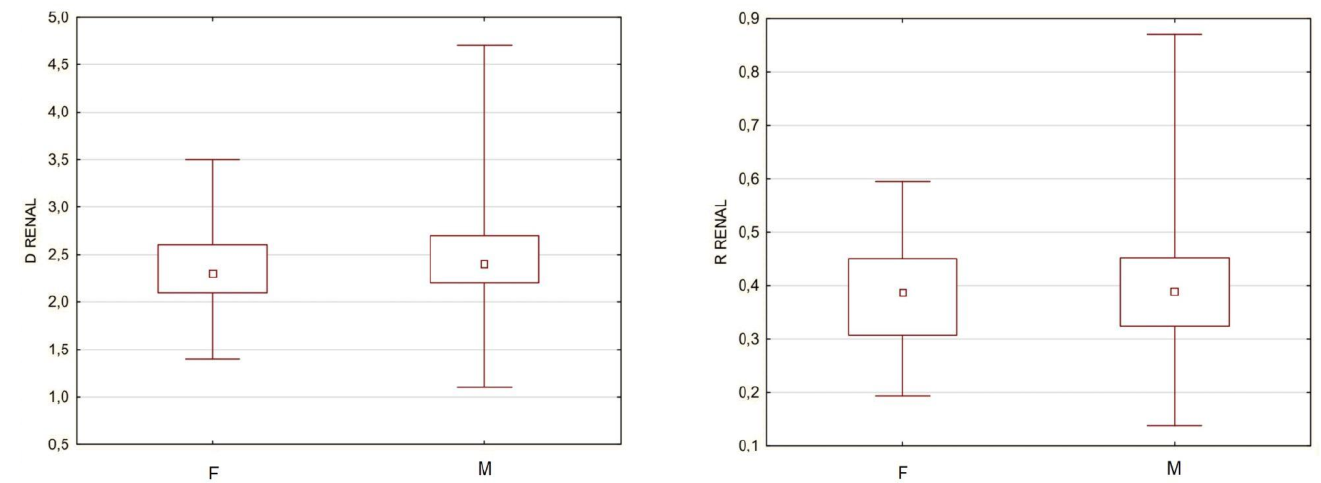
Figure 2. A comparison of aorta diameter (D RENAL) and renal ratio (R RENAL) between women (F) and men (M). D Renal for women from 1.4 to 3.5 cm with majority from 2.1 to 2.6 cm, D Renal for men from 1.1 to 4.7 cm with majority from 2.2 to 2.7 cm. R Renal for women from 0.2 to 0.6 with majority from 0.3 to 0.45, R renal for men from 0.14 to 0.88 with majority form 0.32 to 0.45. All dif- ferences insignificant p > 0.05.